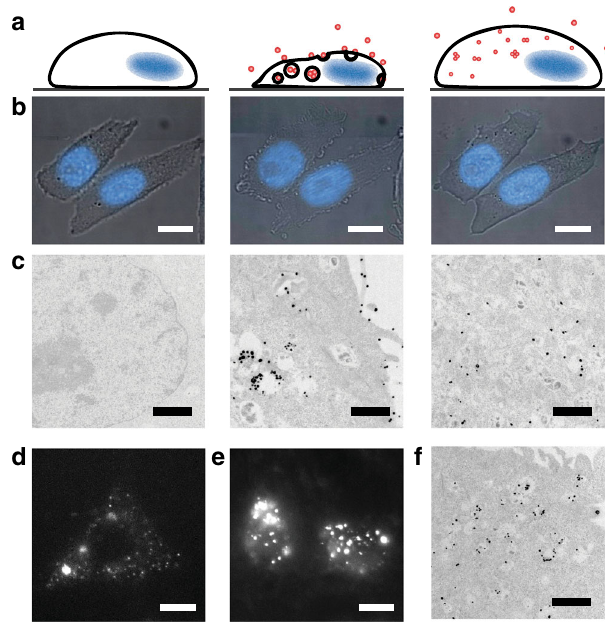
Fig. 2 Quantum dot delivery to CHO cells by osmotic pinosome lysis. a Schematic of osmotic pinosome lysis (OPL), depicting changes in cell morphology and location of quantum dots (QDs) for cells prior to treatment, during hypertonic loading of QDs, and after hypotonic treatment to rupture pinosomes. b Bright fi eld images with nuclear stain (blue) demonstrating morphological changes of cells undergoing OPL, at stages corresponding to schematics in a . c Transmission electron microscopy (TEM) images of OPL-mediated delivery of QDs, corresponding to schematics in a , where the particles can be seen primarily trapped in the endosomes, and then dispersed in the cytoplasm. d Fluorescence HILO image of QDs delivered via OPL and e via passive uptake. f TEM image of cells after passive uptake. Scale bars are 10 μ m for light microscopy images and 1 μ m for TEM images. Additional TEM images are in Supplementary Fig.